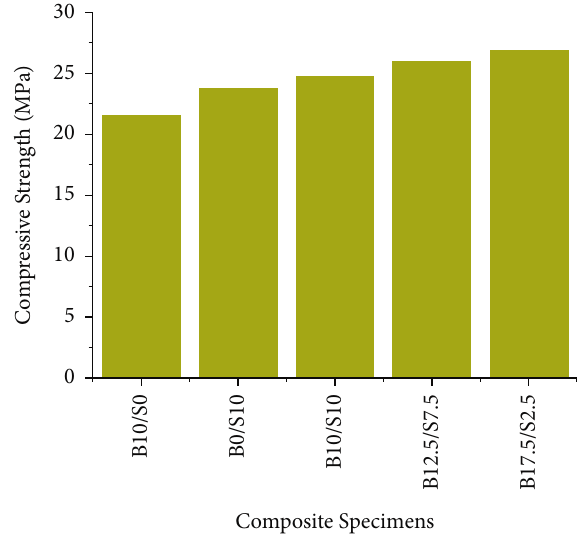
Figure 8: Compressive strength of the composite